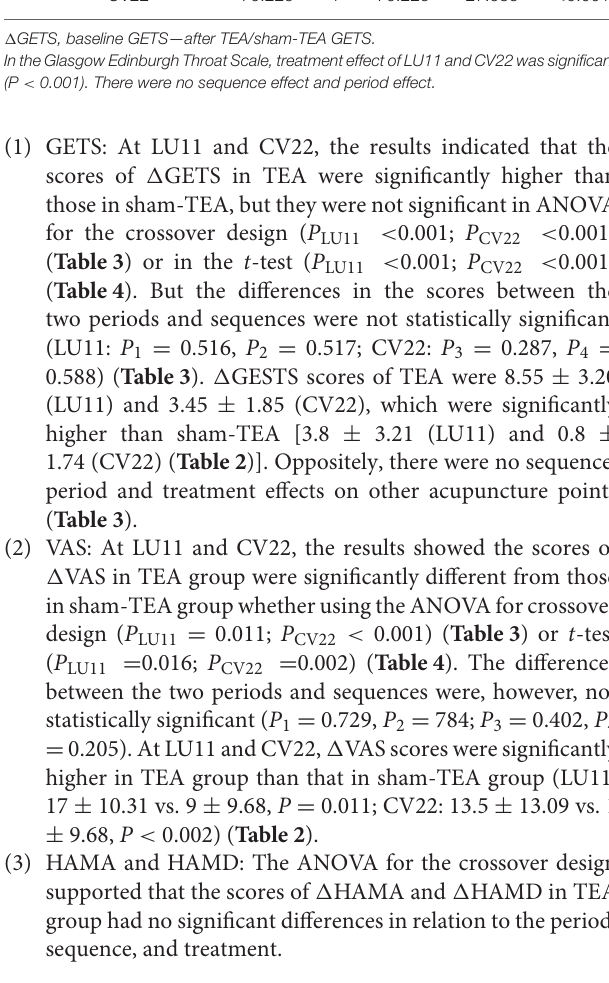
of 1 SP ( P = 0.009; P < 0.001) ( Figure 3 ) and 1 NPY ( P = 0.037; P = 0.029) ( Figure 4 ) indicated that there were significant differences between before and after TEA when patients